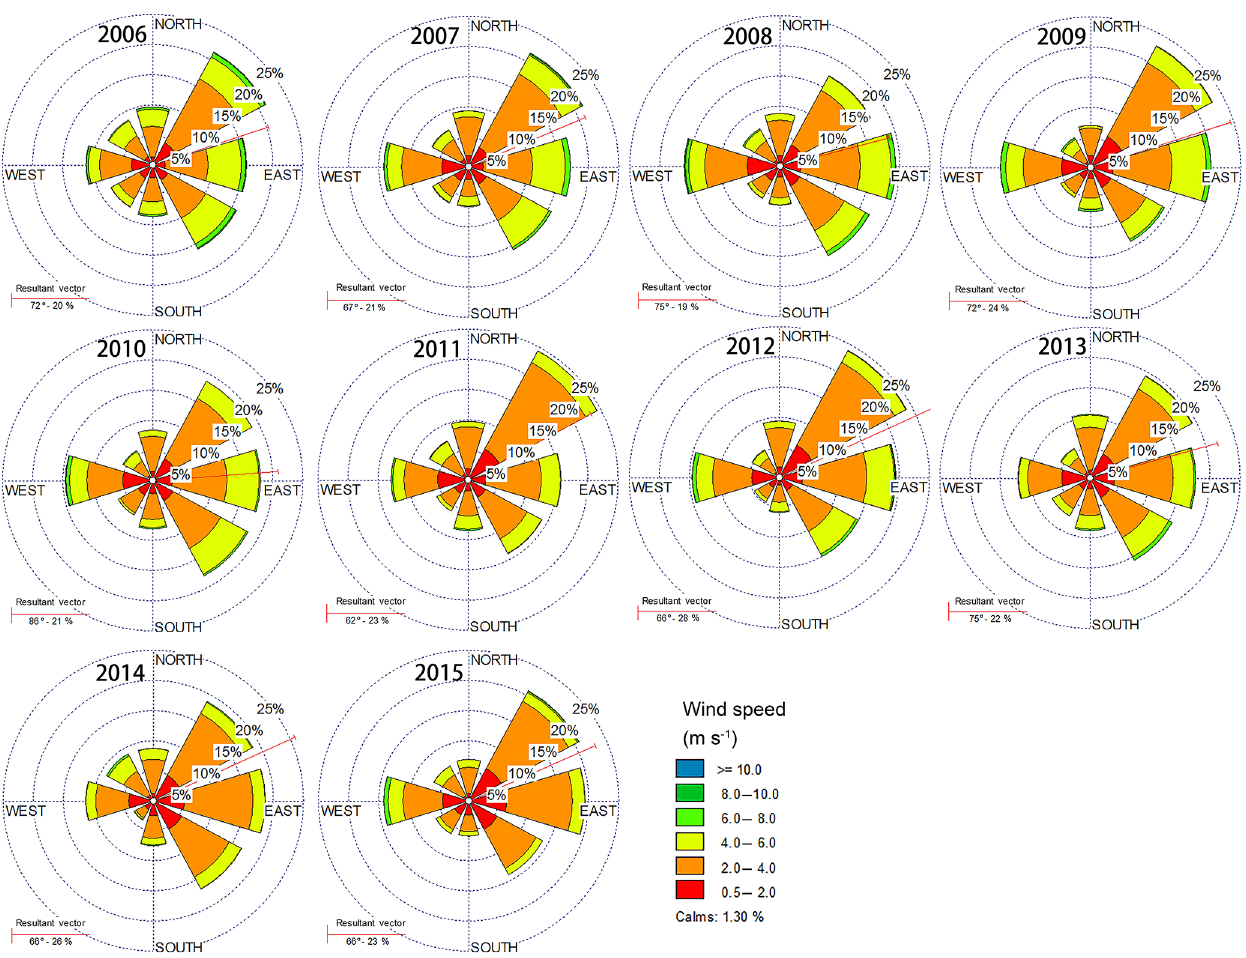
Figure 5. The wind rose of each year from 2006 to 2015 in Shanghai. The red line denotes the resultant vector suggesting the dominant wind